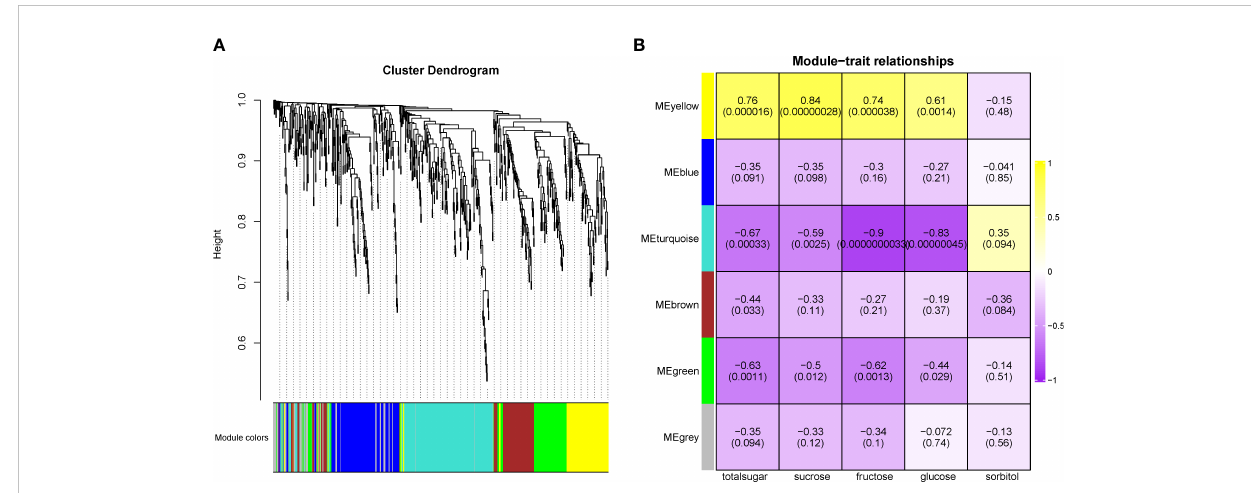
FIGURE 7 Weighted gene co-expression network analysis in genes related to QTL loci. (A) The cluster dendrogram in 649 genes. (B) The relationship between modules and